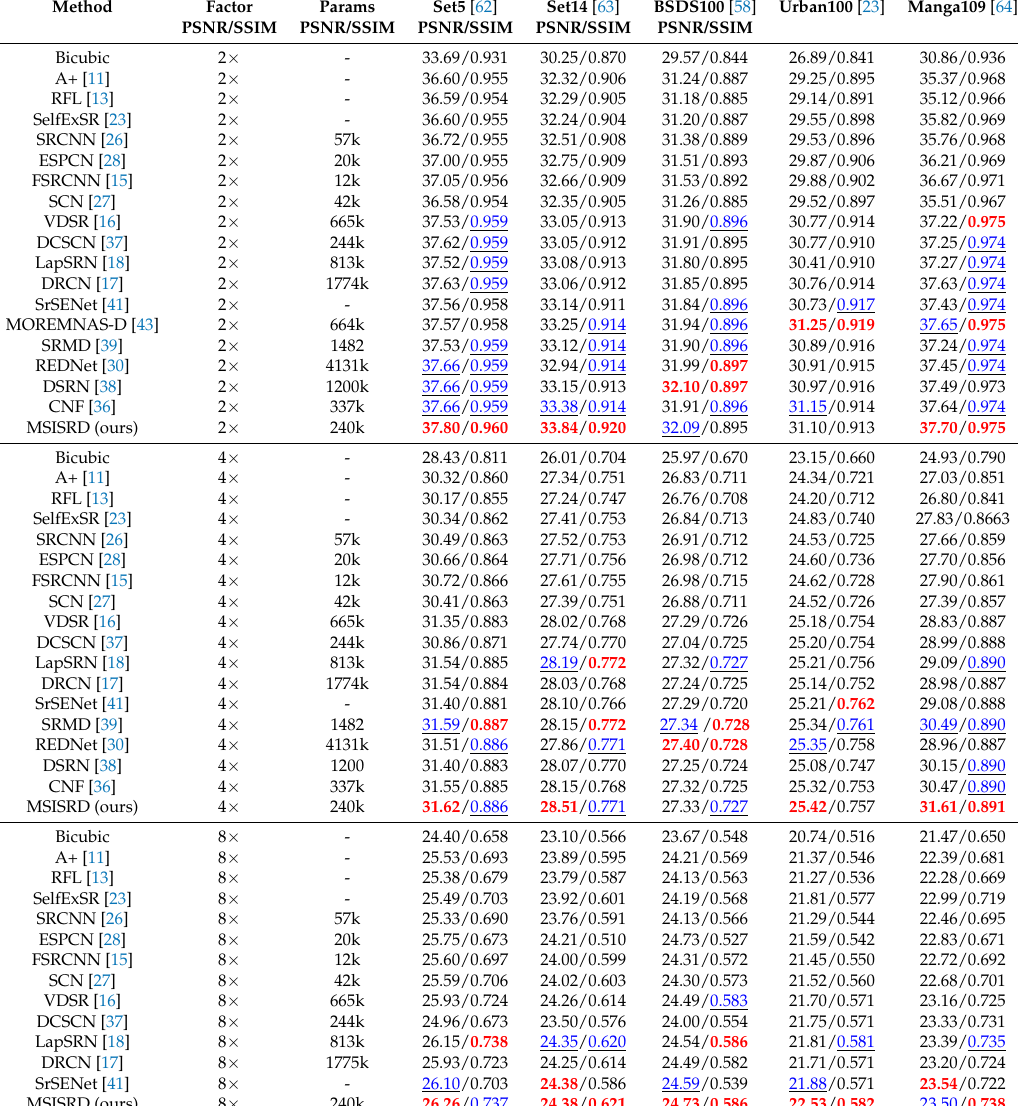
Table 2. Quantitative evaluation of existing SR algorithms with our proposed approach; reported results is the average value of peak signal-to-noise ratio (PSNR) and structural similarity index (SSIM) [56] using 2 × , 4 × , and 8 × enlargement scale factors; red color with bold value indicates the best value, and the blue color with underline indicates the second best value.